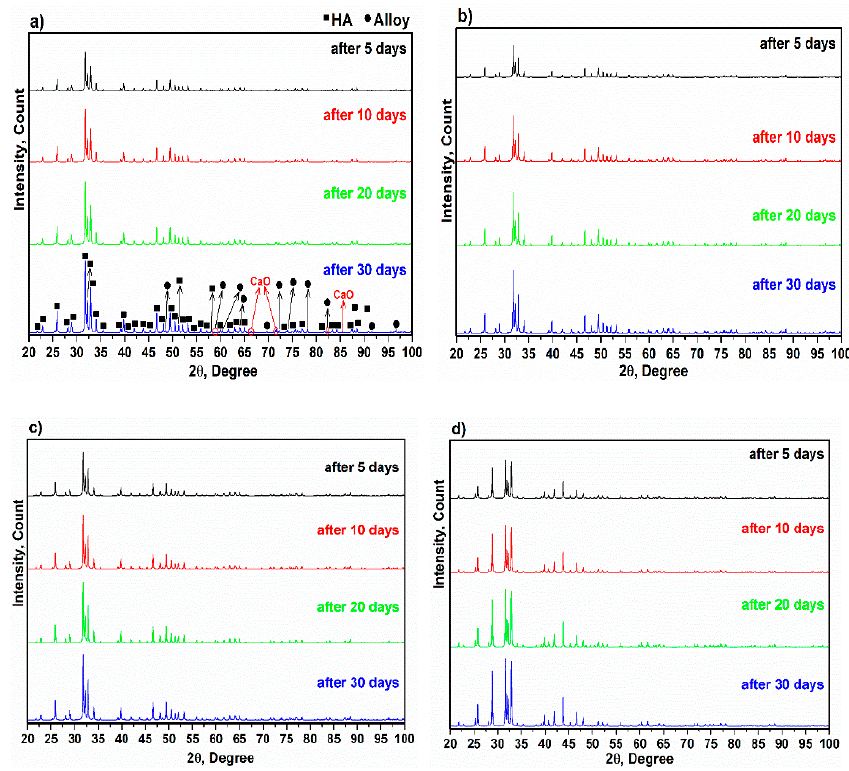
Figure 12. X-ray diffraction of immersed specimens in SBF after 5, 10, 20 and 30 days. ( a ) Alloy, ( b ) C1, ( c ) C2 and ( d ) C3.